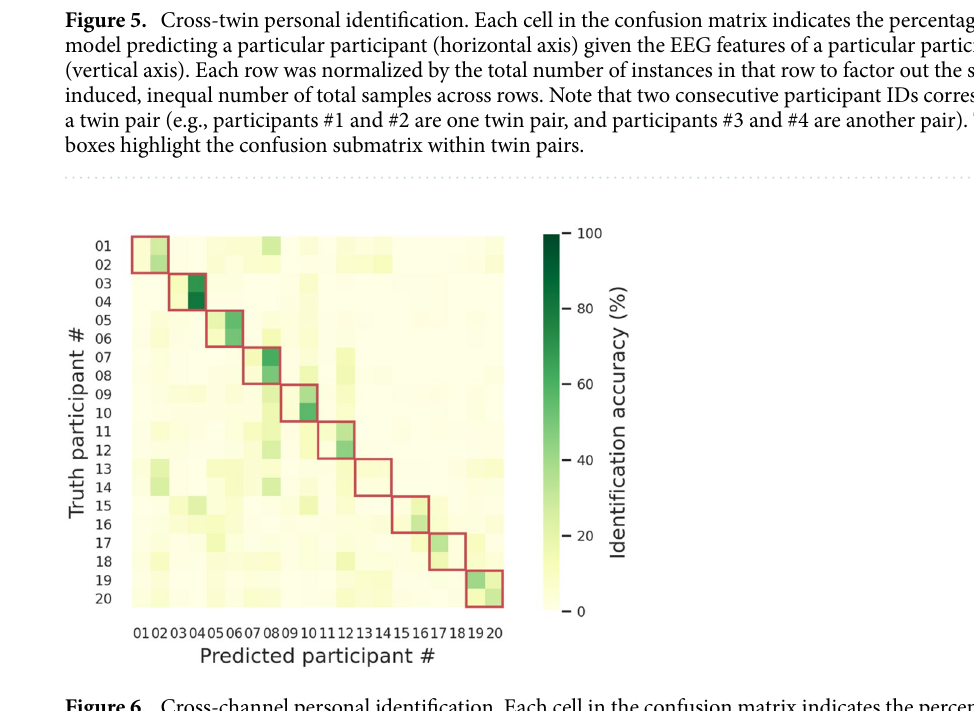
Figure 6. Cross-channel personal identification. Each cell in the confusion matrix indicates the percentage of the model predicting a particular participant (horizontal axis) given the EEG features of a particular participant (vertical axis). Each row was normalized by the total number of instances in that row to factor out the sampling- induced, inequal number of total samples across rows. Note that two consecutive participant IDs correspond to a twin pair (e.g., participants #1 and #2 are one twin pair, and participants #3 and #4 are another pair). The red boxes highlight the confusion submatrix within twin